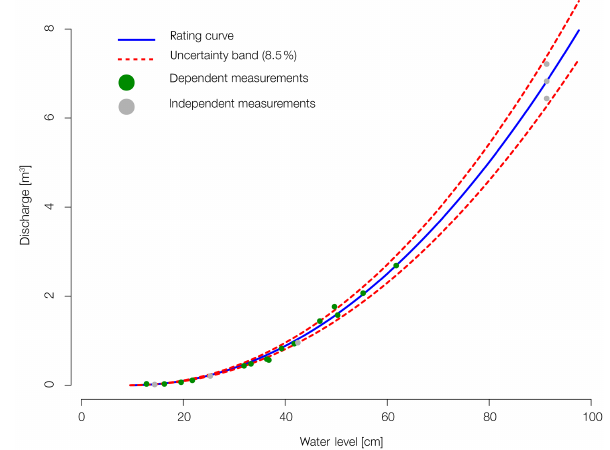
Figure A1. Rating curve of the Colpach gauge. Green dots were used to estimate the rating curve and gray dots independent dis- charge measurements.